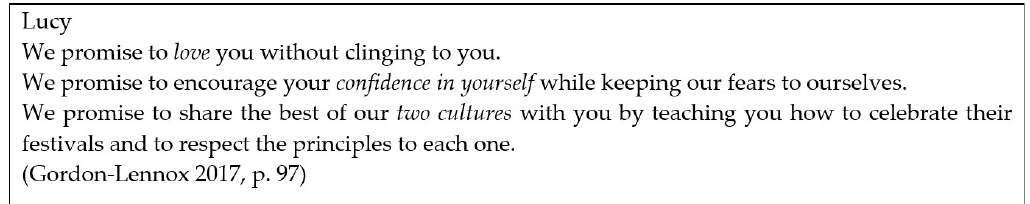
Figure 2. Example of parents’ promise to baby.